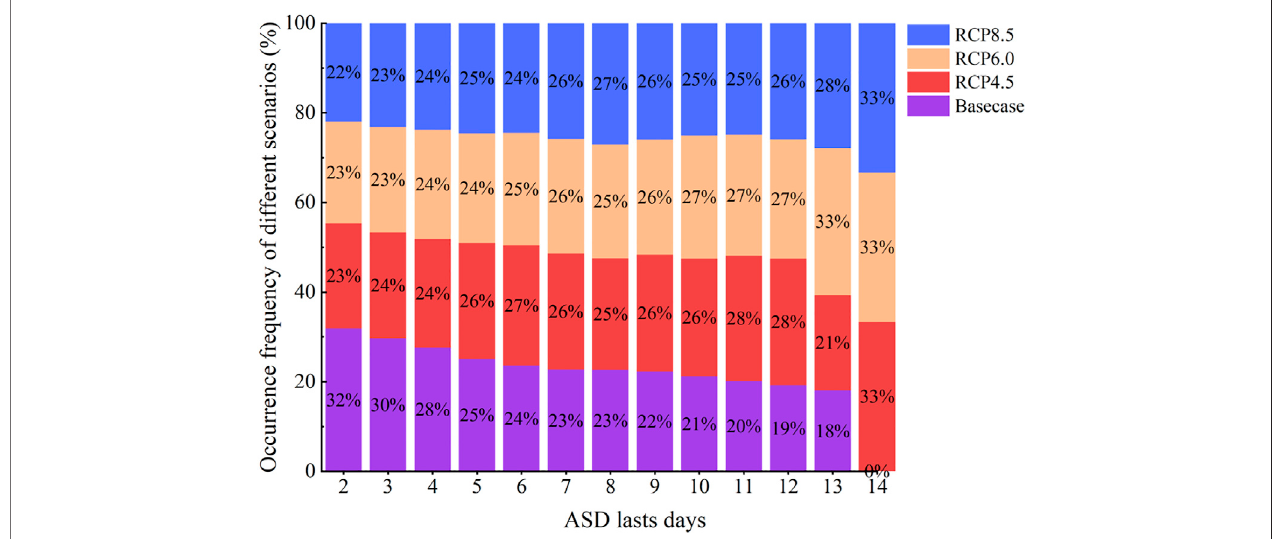
FIGURE 7 | The probability distribution of the number of days that ASE lasted under different representative concentration pathway, (RCP) scenarios.